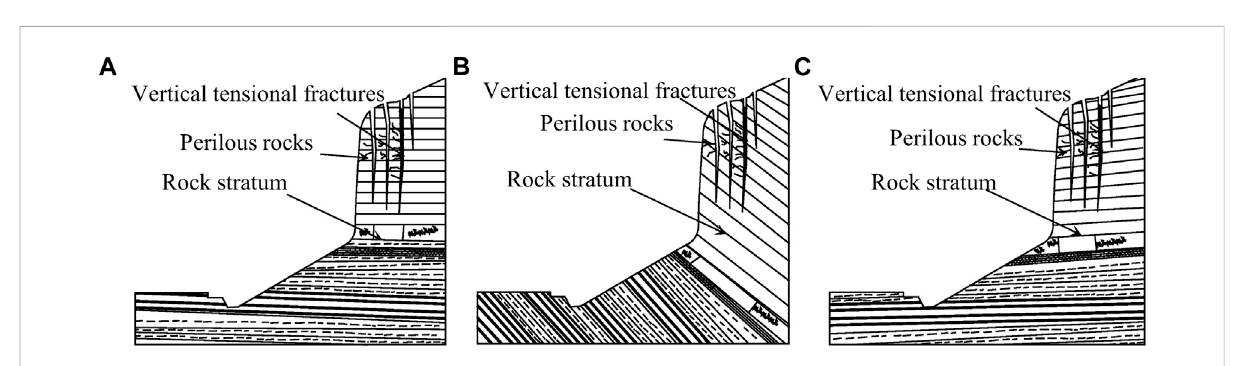
FIGURE 2 Geologic environment of dangerous rocks on cliffs. (A) Level layer. (B) Inverse layer. (C) Bedding